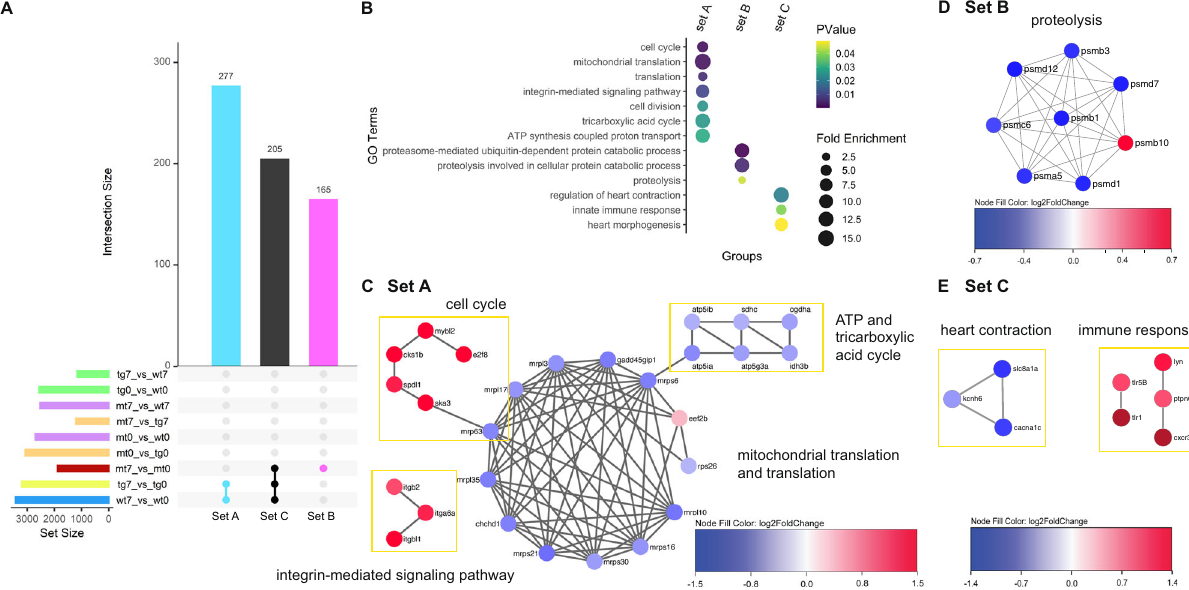
Fig. 5 Network analysis underscores proliferative failure and proteolysis dampening in Nkx2.5 loss-of-function model. A UpSet plot representing DEGs (FC > 0.5; FDR < 0.05) in nine relevant comparisons. Only selected interactions are illustrated: set A (turquoise) – only non-transgenic and transgenic wild- type-speci fi c DEGs following injury, set B (magenta) – only nkx2.5 − / − -speci fi c DEGs following injury, and set C (black) – DEGs common in non-transgenic wild-type, transgenic wild-type, and nkx2.5 − / − fi sh following injury. B GO analysis of sets A, B, and C. All signi fi cantly enriched GO terms from each set are included for analysis by DAVID. Color and size of circles correspond to log (q-value) and enrichment, respectively. C – E Network analyses of genes associated with signi fi cantly enriched GO terms from set A ( C ), set B ( D ), and set C ( E ). Color represents the fold change in injured compared to uninjured wild-type CMs (WT7 vs WT0) ( C , E ) and injured compared to uninjured nkx2.5 − / − CMs (MT7 vs MT0) ( D ). Red is upregulated and blue is downregulated, as shown in the